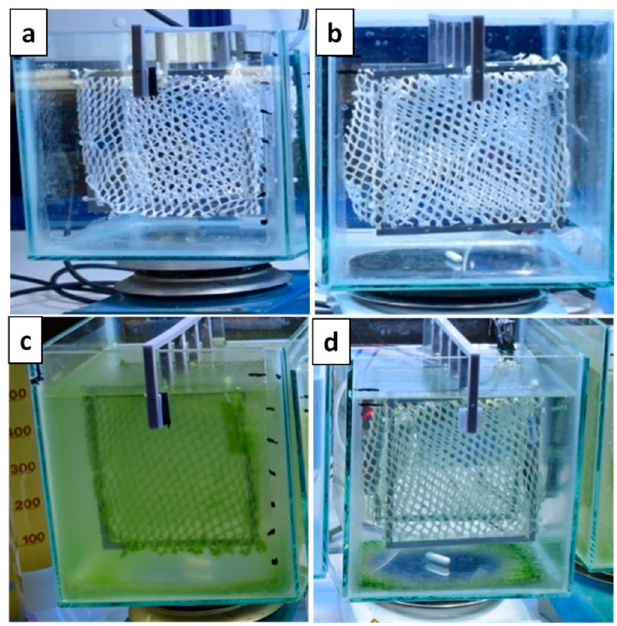
Figure 6. Photographs of the coated ( b , d ) and uncoated nets ( a , c ) after immersion in seawater solution the first day ( a , b ) and after seven days ( c , d ) in accelerated conditions. Table 1. Measured physicochemical parameters in the tanks with the uncoated (uc) and coated (c)